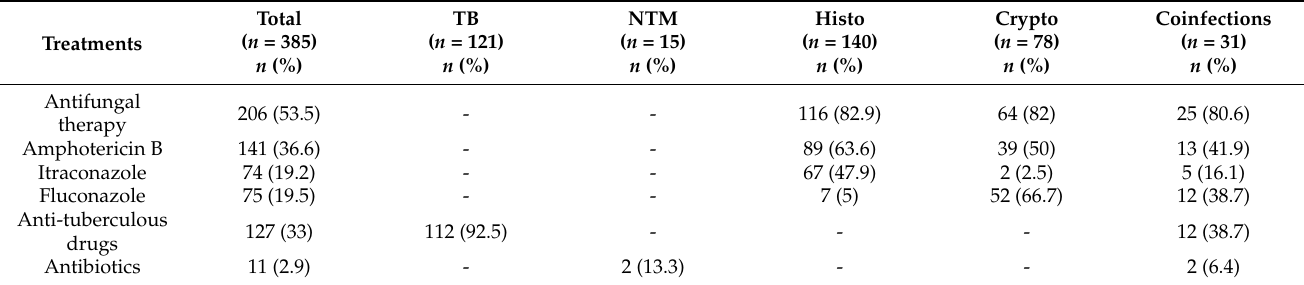
Table 4. Opportunistic infection